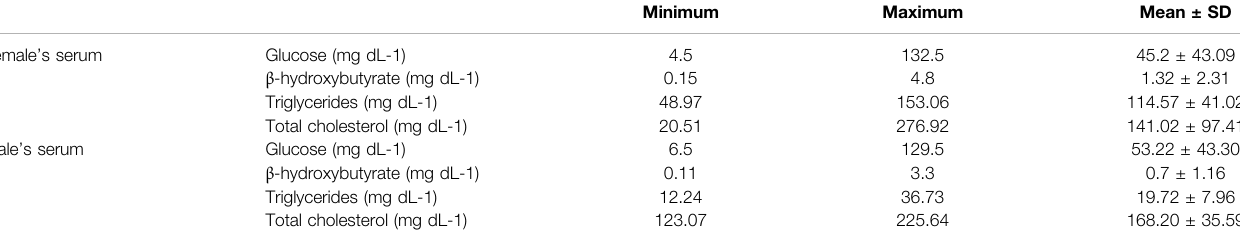
TABLE 2 | Minimum, maximum, and mean concentrations, and standard deviations of the analyzed P. horkelii serum markers. Concentrations are presented as mg dL -1 .